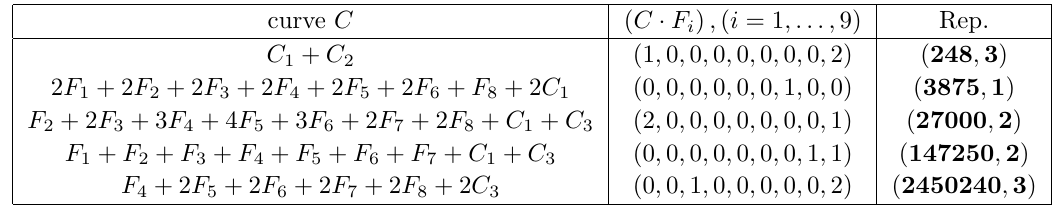
Table 3 . The rational (0)-curves giving rise to spin 1 BPS states on the CFD of the SCFT with G F = E 8 (cid:2)